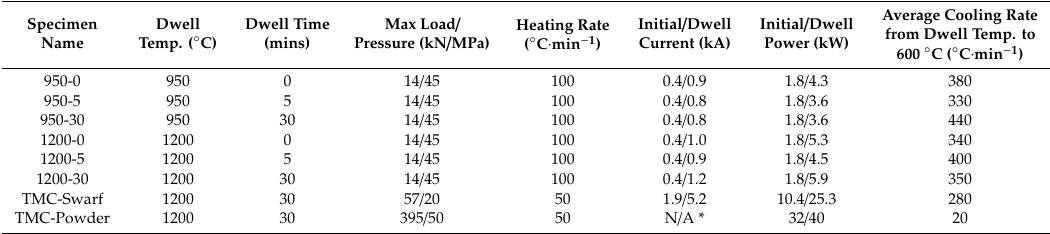
Table 2. FAST cycle parameters for the processed Ti-6Al-4V